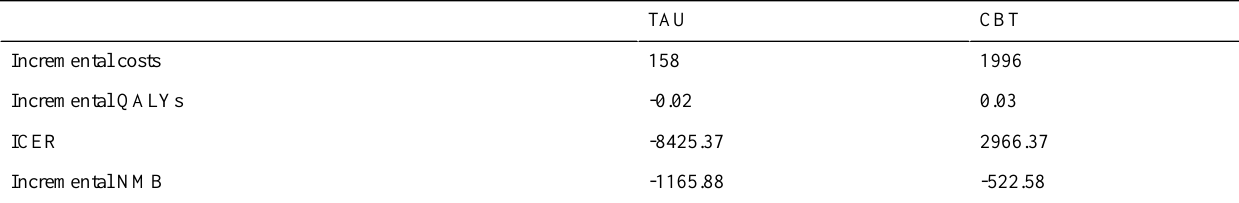
Table 4. Incremental results, myCompass versus comparators.